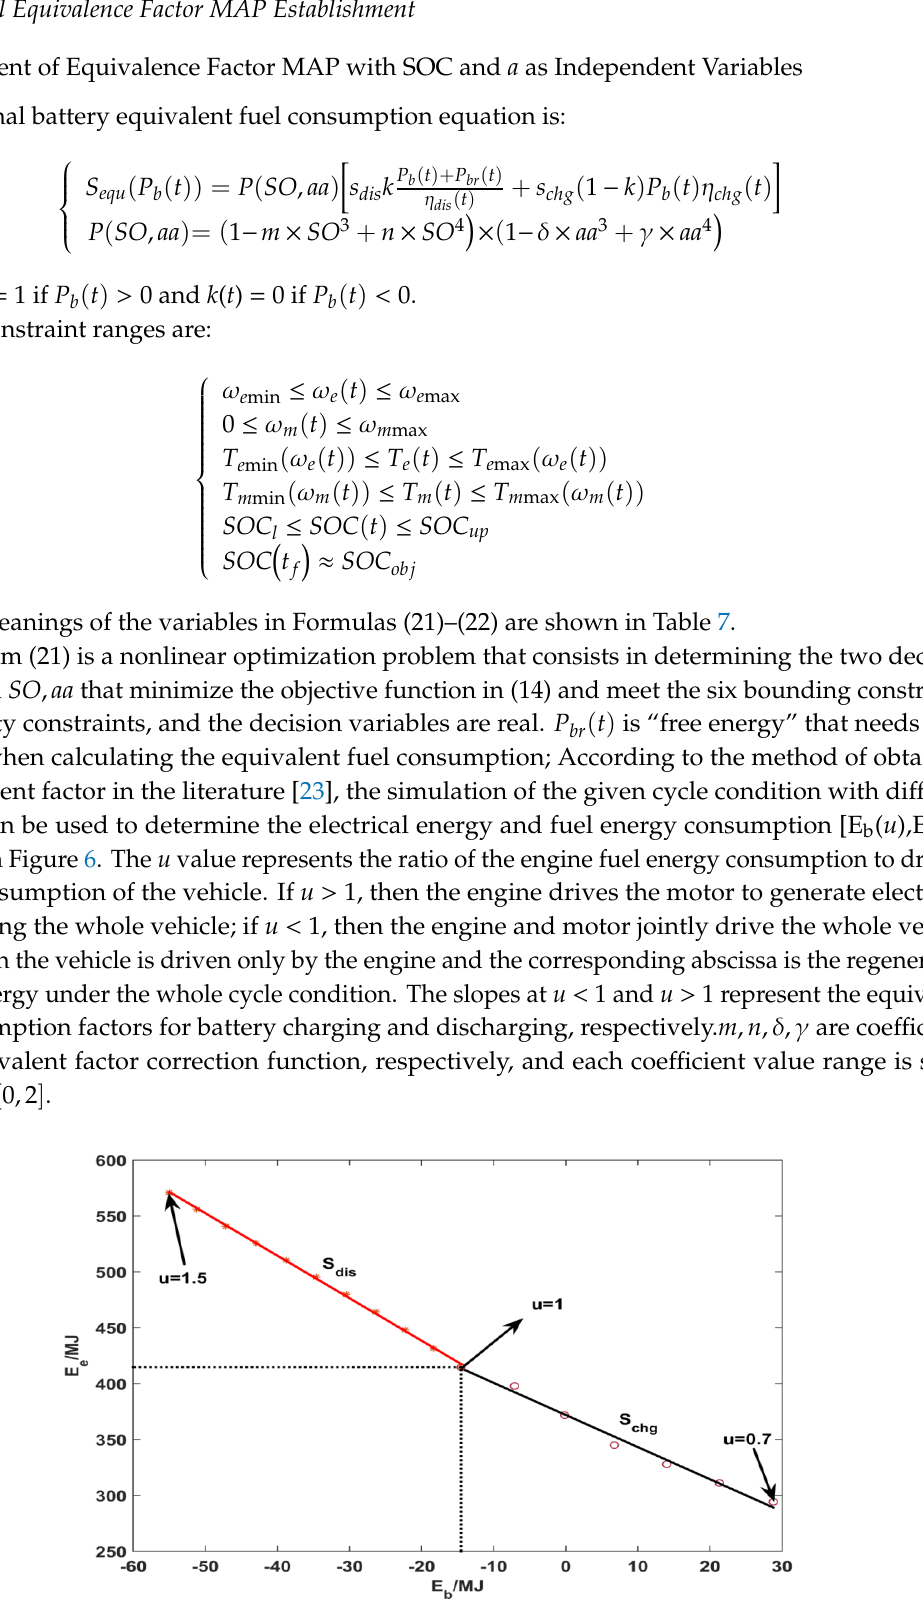
Figure 7. Global optimization model based on GA. 4.3. Improved ECMS Real-Time Optimization Solution For a single-shaft parallel hybrid vehicle, the engine and motor are coaxially connected in parallel. The engine speed in the hybrid drive mode is not a controlled variable; thus, the torque becomes the only control variable of the energy management strategy. The power distribution at this time is equivalent to the torque distribution [24]. Therefore, the torque of the motor is used as the control variable. Under the premise of driving and satisfying the dynamics of vehicle conditions, the torque of the motor was gradually increased from